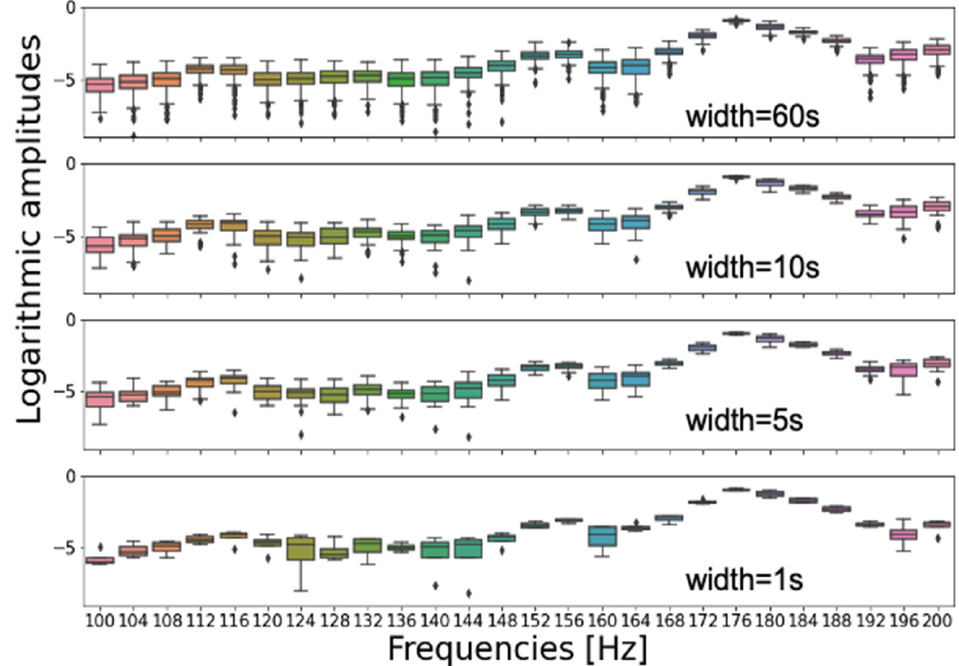
Figure 5. One-second intervals were found to be sufficiently representative of the STFT amplitude variability when examining this variability over a range of intervals, including 1, 5, 10 and 60 s, as shown in the subpanels, for all frequencies up to 20 kHz. For illustration, the amplitude variability is only shown for frequencies in the range of 100 to 200 Hz.